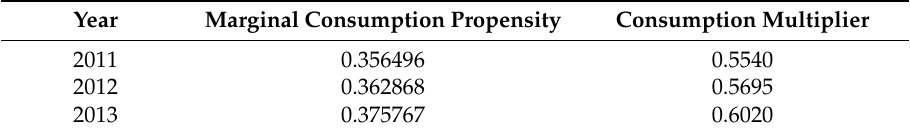
Table 5. Marginal consumption propensity and consumption multiplier of BTH from 2011 to 2013.